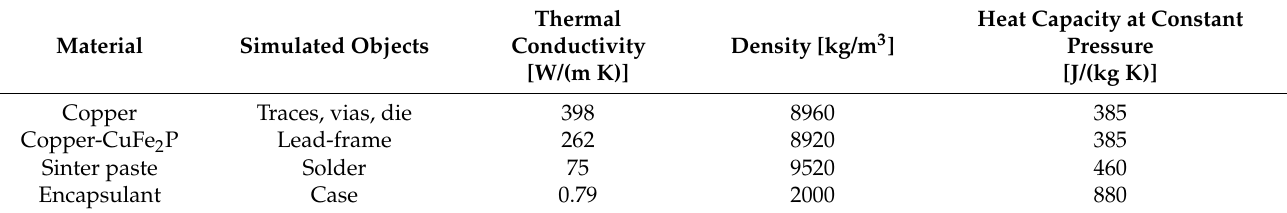
Table 2. Material properties used for thermal